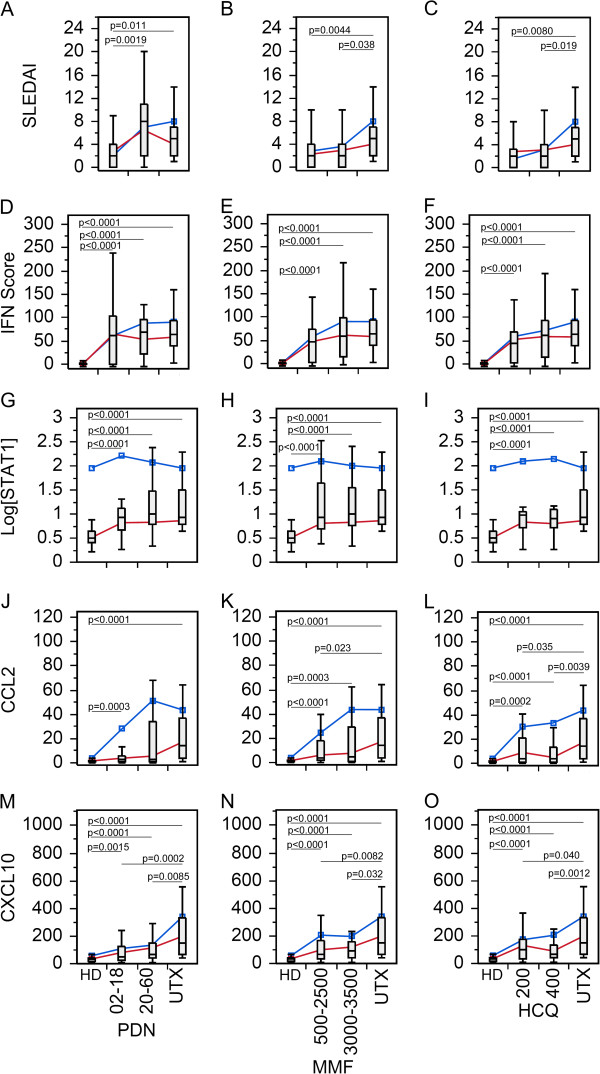
Comparison of the levels of various biomarkers in the SLE patient visits given PDN, MMF, and HCQ therapy at high or low dosage. Differences between doses of PDN (D, G, J, M), MMF (B, E, H, K, N), and HCQ (C, F, I, L, O) were not significant with the exception of SLEDAI (A), and in fact SLEDAI scores were higher for PDN dose of 20 to 60 mg/day compared to the 2 to 18 mg/day of dose. HCQ, hydroxychloroquine; MMF, mycophenolate mofetil; PDN, prednisone; SLE, systemic lupus erythematosus; SLEDAI, SLE disease activity index.